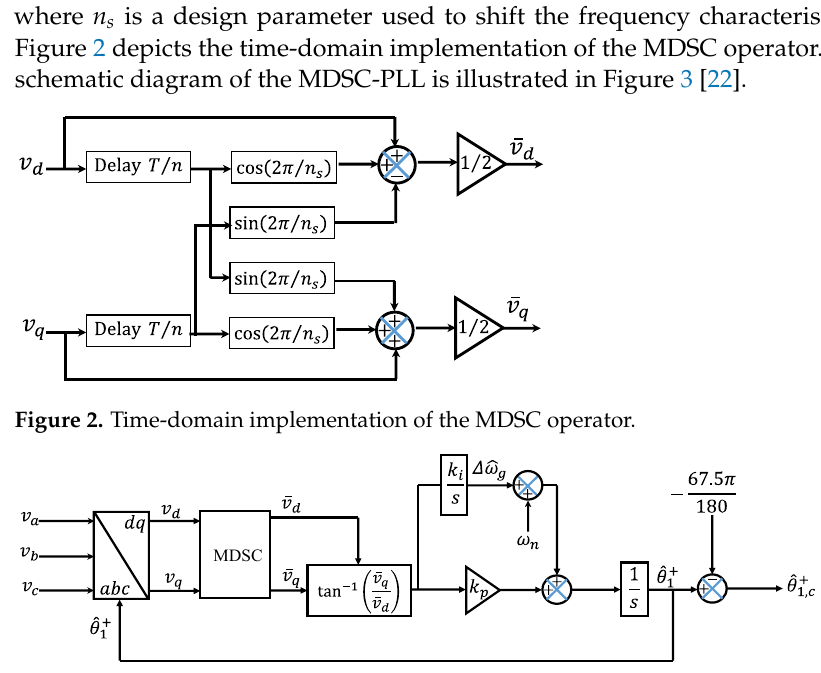
Figure 3. Schematic diagram of the MDSC-PLL.